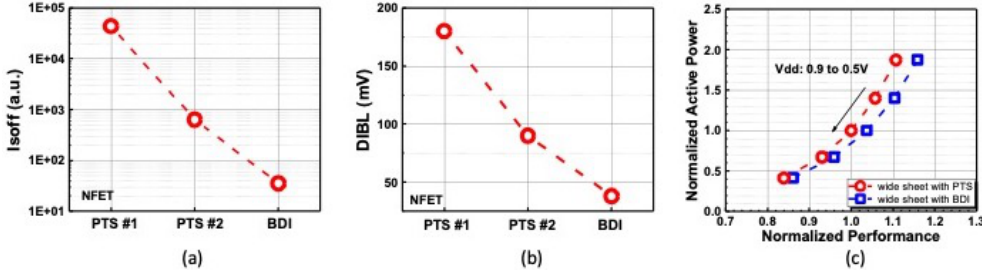
Figure 4. This figure captures key performance metrics for GAA FETs using PTS scheme and full BDI. ( a ) I sof f extracted from L g =12 nm devices on PTS and BDI splits. ( b ) DIBL extracted from L g =12 nm devices on BDI and PTS splits. ( c ) Power vs. performance correlation chart of wide sheet devices for both with and without BDI layer